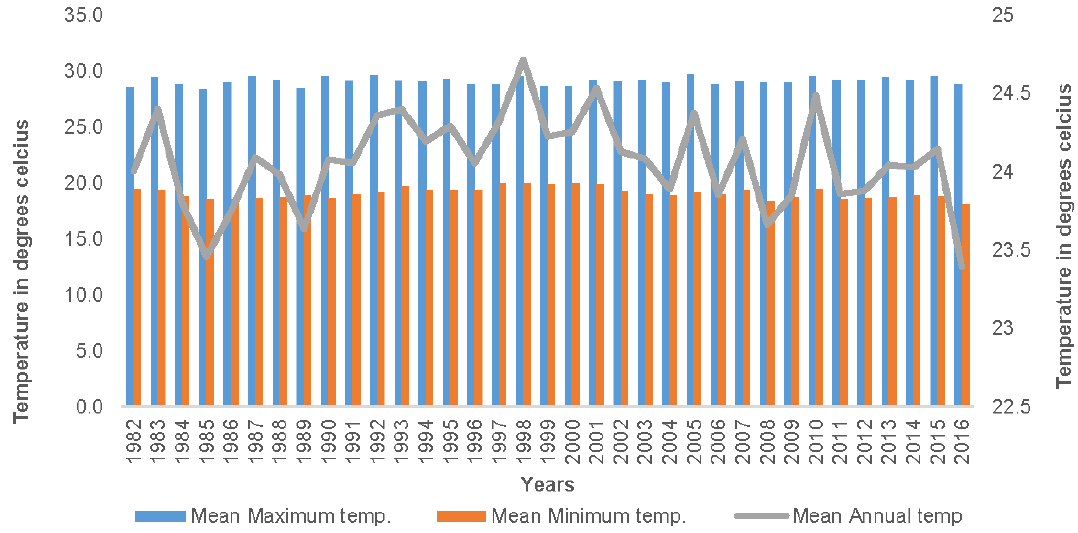
Figure 5. Mean annual maximum, mean annual minimum and mean temperatures for Dwangwa, Nkhotakota, Malawi in 1982 – 2016.